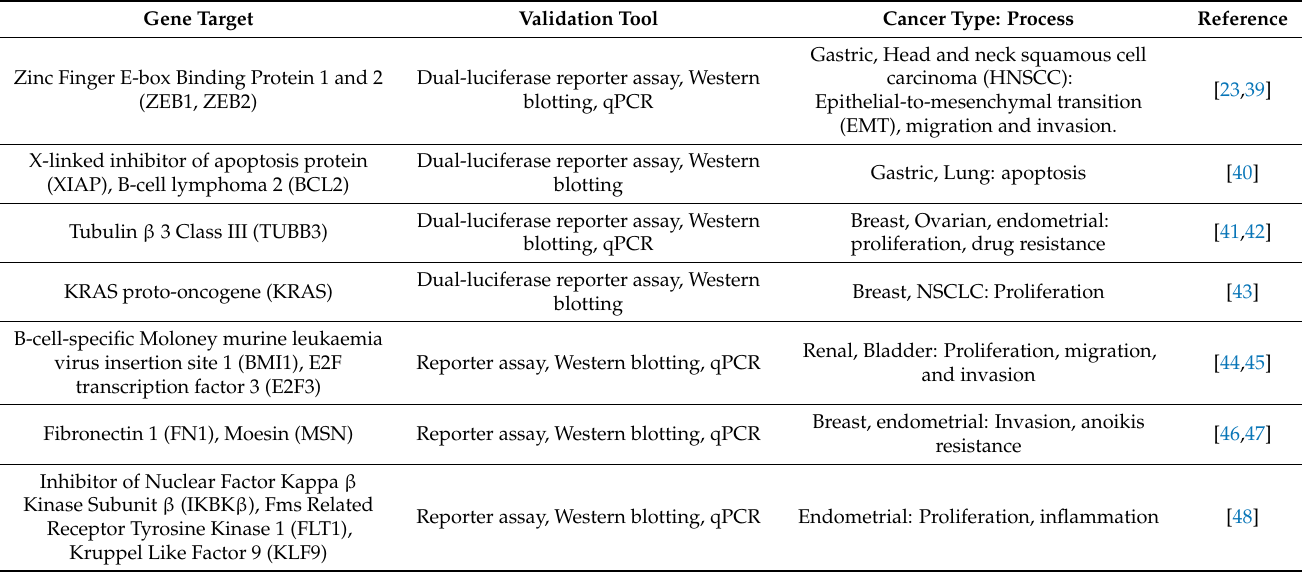
Table 2. Selected list of experimentally validated gene targets of hsa-miR-200c-3p and the supporting literature. Gene